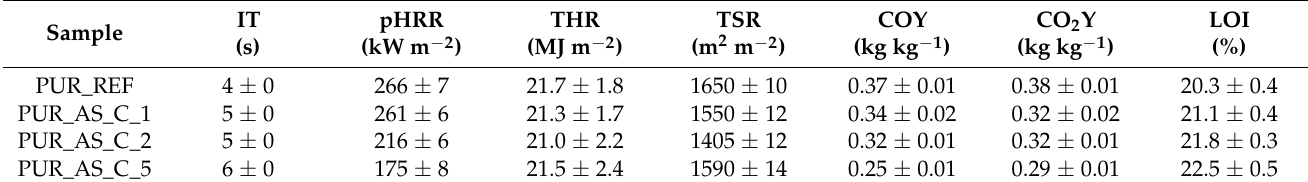
Table 4. The results of the cone calorimeter test.